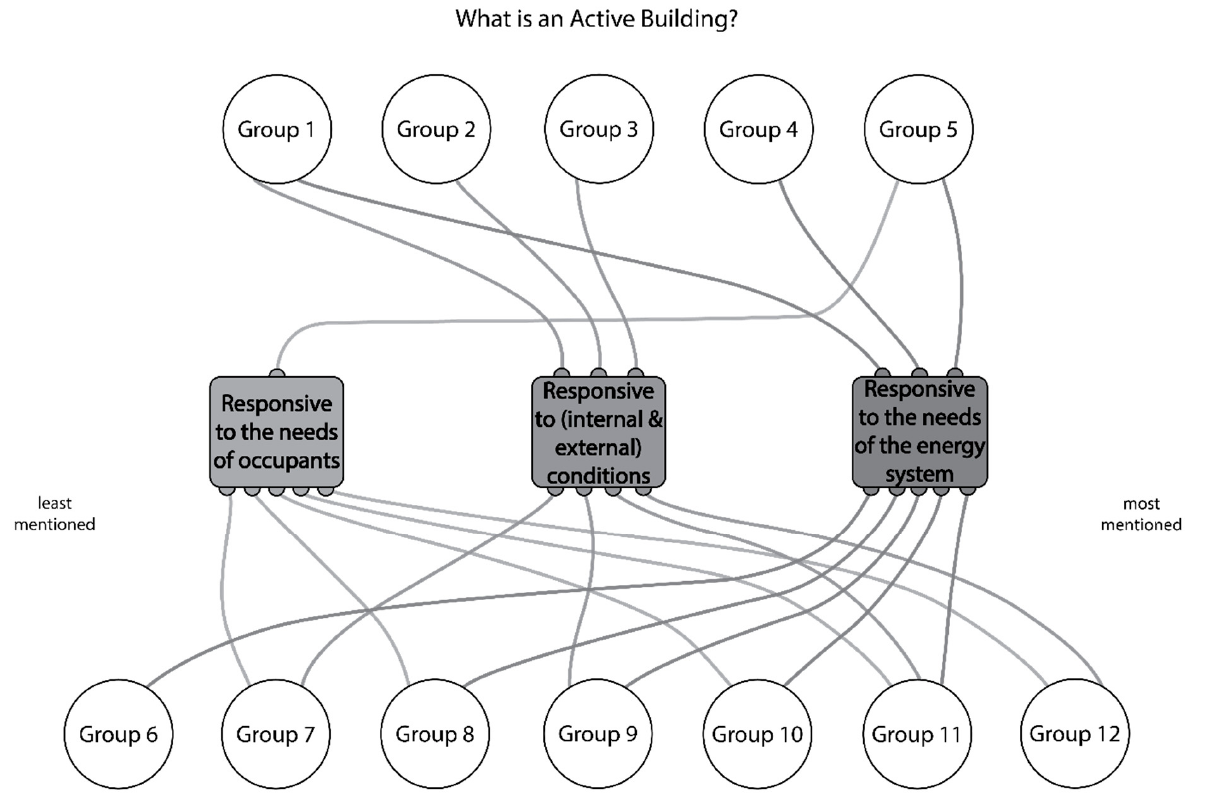
Figure 3. Definitions of an active building according to different groups of stakeholders.